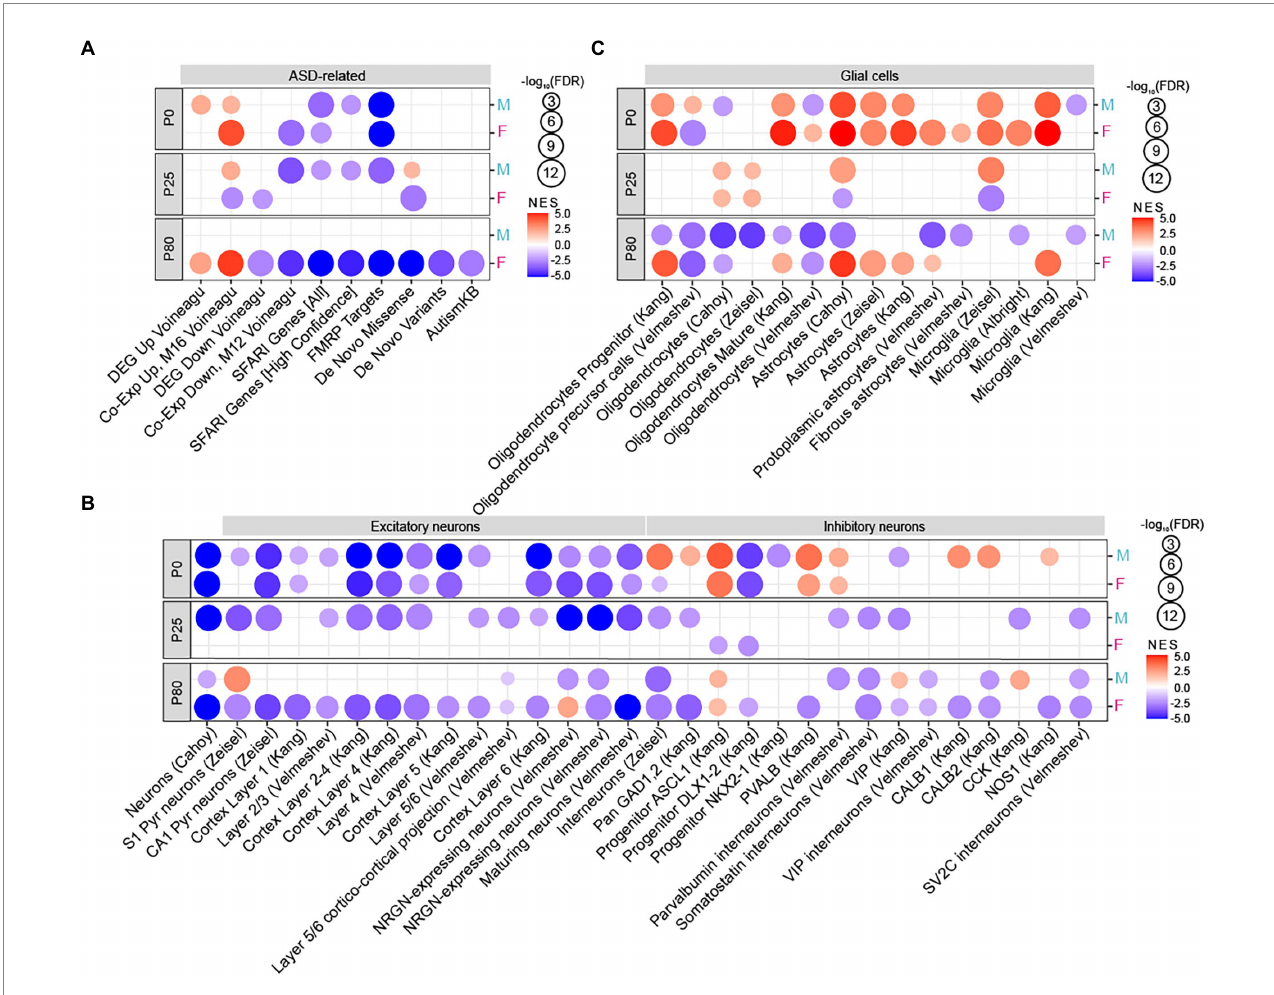
FIGURE 4 Age-differential ASD-like transcriptomic changes in adult Chd8+/S62X males and females. (A) GSEA of P0, P25, and P80 male and female HT/WT transcripts for ASD-related/risk gene sets, including those upregulated in ASD (DEG_Up_Voineagu and Co-Exp_Up_M16_Voineagu) and downregulated in ASD (DEG_Down_Voineagu and Co-Exp_Down_M12_Voineagu) as well as ASD-risk gene sets that are likely downregulated in ASD (SFARI [all], SFARI [high confidence], FMRP targets, DeNovoMis, DeNovoVariants, and AutismKB). (see Supplementary Tables S5–S7 for full results). ( n = 3 mice for P0/25/80, male/ female, and WT/HT mice, FDR < 0.05). (B) GSEA of P0, P25, and P80 male and female HT/WT transcripts for cell-type–specific gene sets related to neurons (cortical layers and GABA sub-types). ( n = 3 mice for P0/25/80, male/female, and WT/HT mice, FDR < 0.05). (C) GSEA of P0, P25, and P80 male and female HT/WT transcripts for cell-type–specific gene sets related to glial cells (oligodendrocytes, astrocytes, and microglia; n = 3 mice for P0/25/80, male/female, and WT/HT mice, FDR < 0.05).